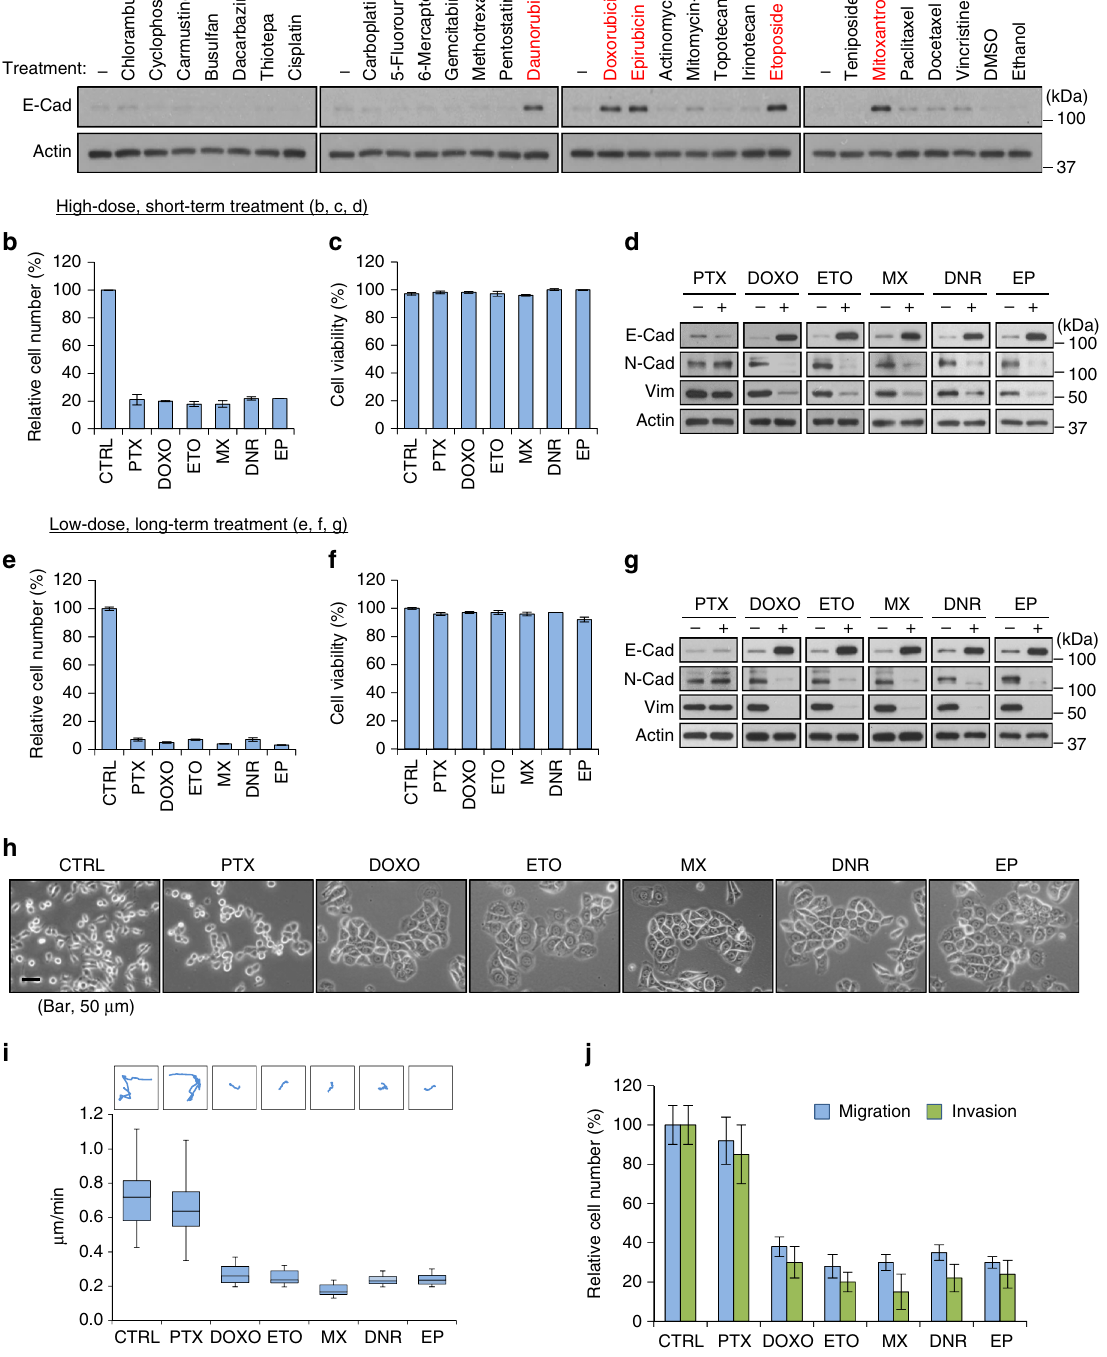
EMT/ β -catenin/STT3/PD-L1 axis is likely through downregula- tion of nuclear β -catenin. In parallel, we observed that TOP2B associated with β -catenin in the nucleus (Fig. 8i, j). Therefore, we rationalized that binding of β -catenin to TOP2B may facilitate nuclear localization of β -catenin and that etoposide degrades TOP2B and subsequently induces cytosolic translocation of nuclear β -catenin, leading to MET and downregulation of STT3 and PD-L1. Elevated E-cadherin stabilizes and traps β -catenin